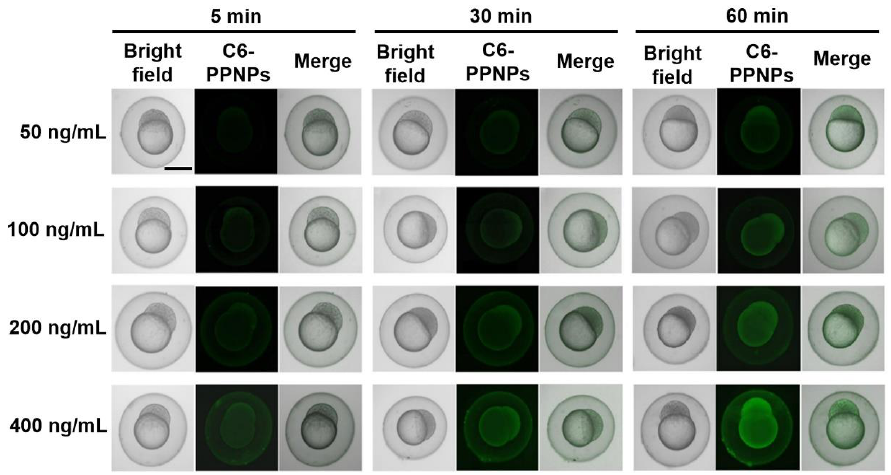
Figure 3. Imaging of zebrafish embryos. Zebrafish embryos (3 hpf) following incubation with C6-PPNPs at C6 concentrations of 50, 100, 200, and 400 ng/mL for 5, 30, and 60 min. Scale bar: 500 μm.